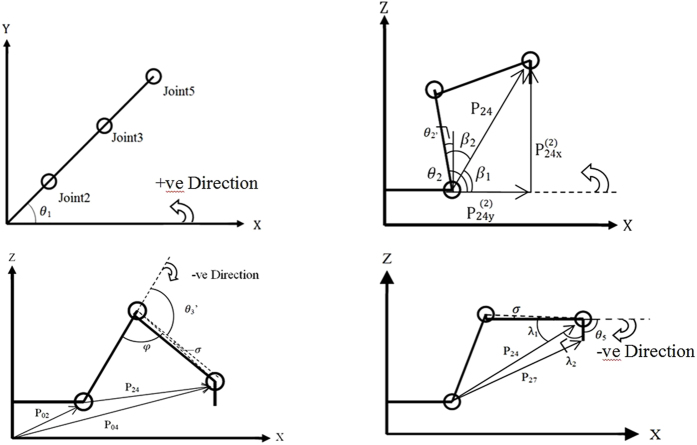
Free body diagram to compute θ1, θ2, θ3, and θ5 respectively51.